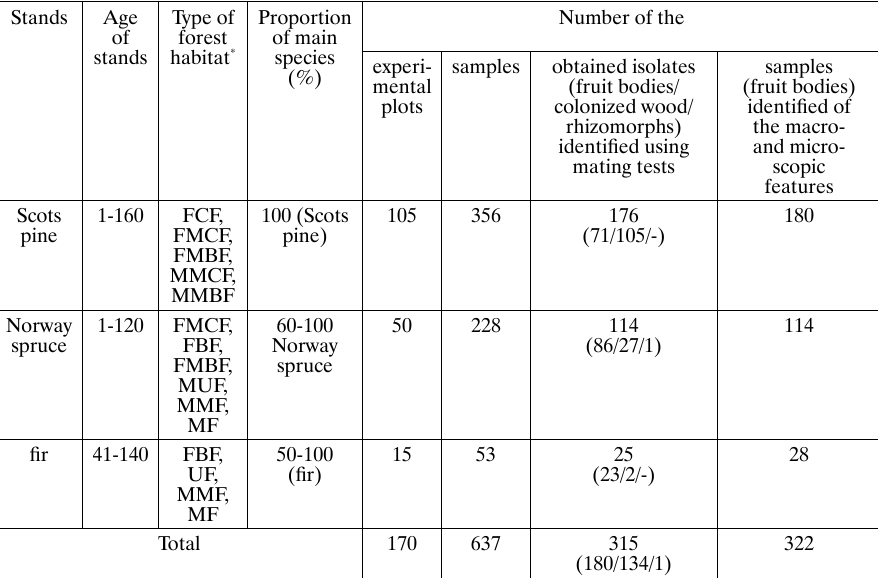
Characterization of stands, from which samples of Armillaria were